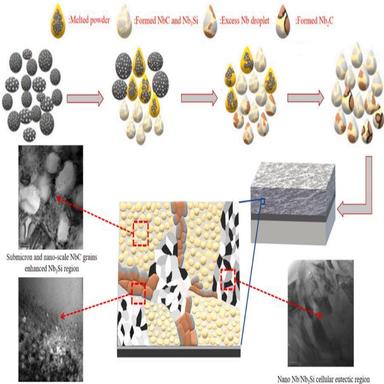
Schematic diagram of the formation mechanism of plasma sprayed Nb–SiC composite coating.